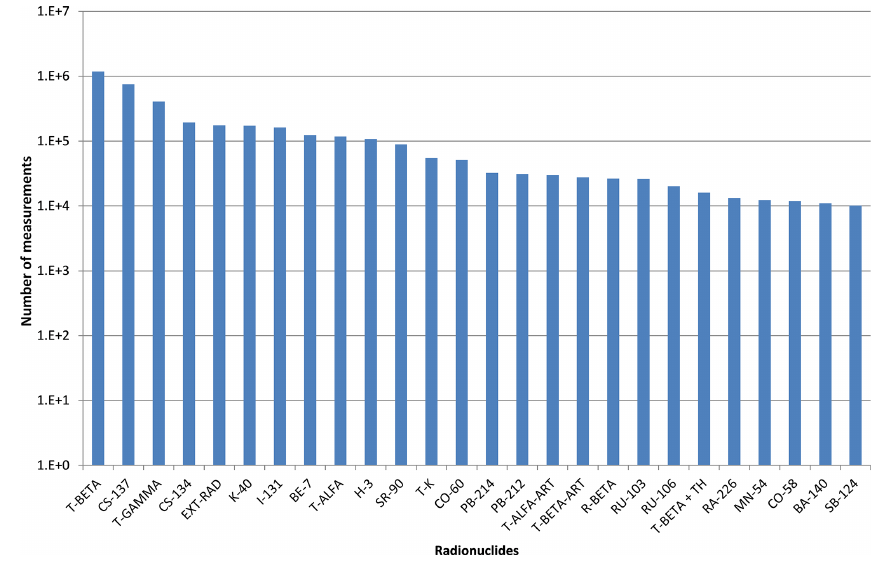
Figure 5. Number of single measurements grouped by radionuclide stored in REMdb; the figure shows just those with a number of mea- surements above 1 × 10 4 .